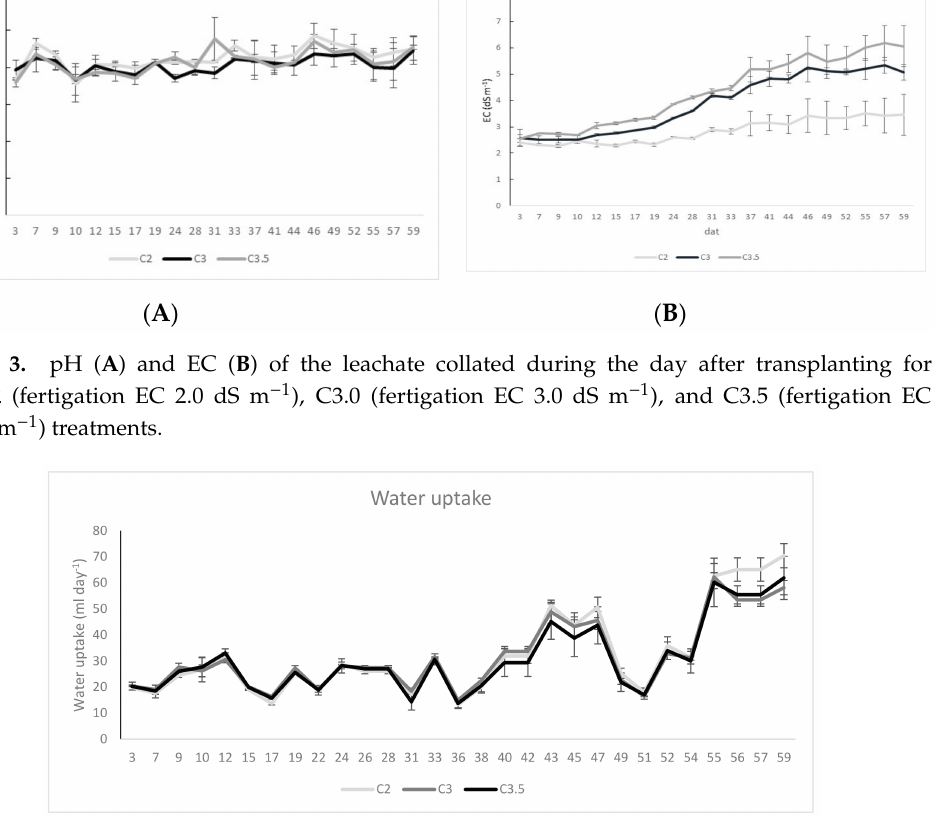
Figure 4. Water uptake during the day after transplanting for the C2 (fertigation EC 2.0 dS m − 1 ), C3.0 (fertigation EC 3.0 dS m − 1 ), and C3.5 (fertigation EC 3.5 dS m − 1 ) treatments.